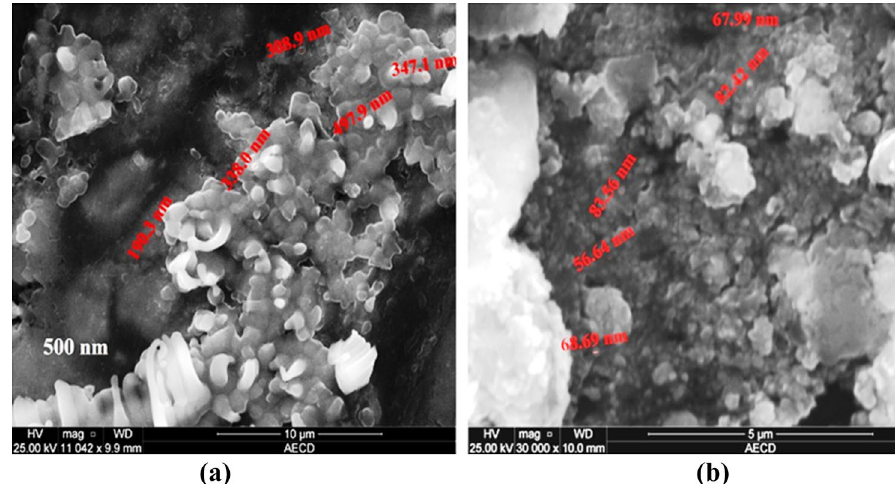
Fig. 4 High- to low-resolution SEM image of Fe 2 O 3 NPs